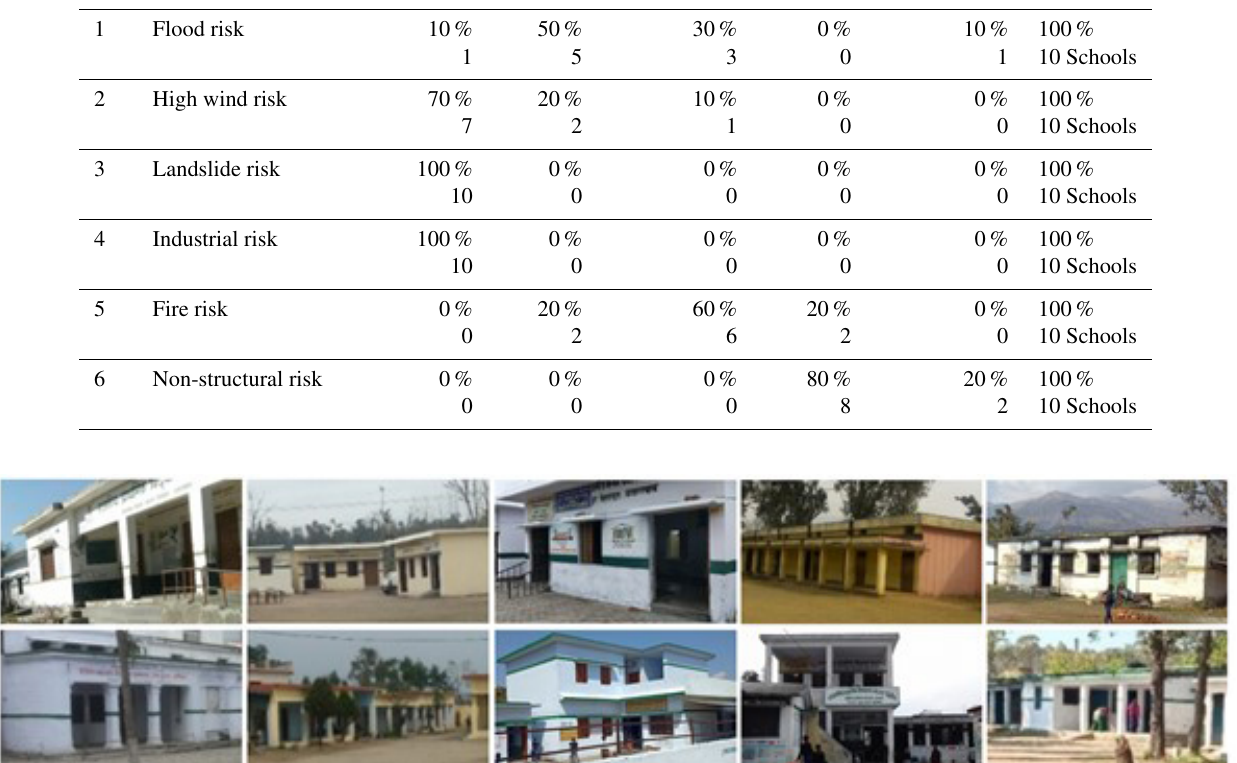
Figure 6. Photo of the 10